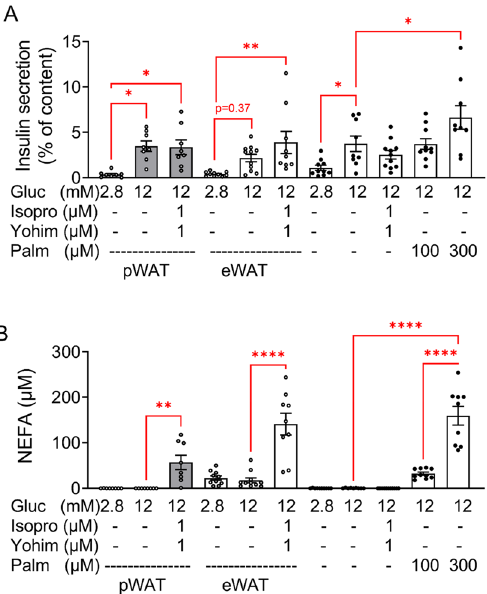
Figure 4. Short term co-incubation of pWAT and eWAT of CD mice with isolated islets of CD mice. Adipose tissue was pre-incubated and islets were isolated, cultured overnight and co-incubated as described under Material and methods. Glucose (Gluc), isoproterenol (Isopro), yohimbine (Yohim), palmitate (Palm) were added as indicated. ( A ) Insulin and ( B ) NEFA were measured in the supernatant. Results are expressed as means ± SEM of n = 8–12 observations of 3 independent experiments.